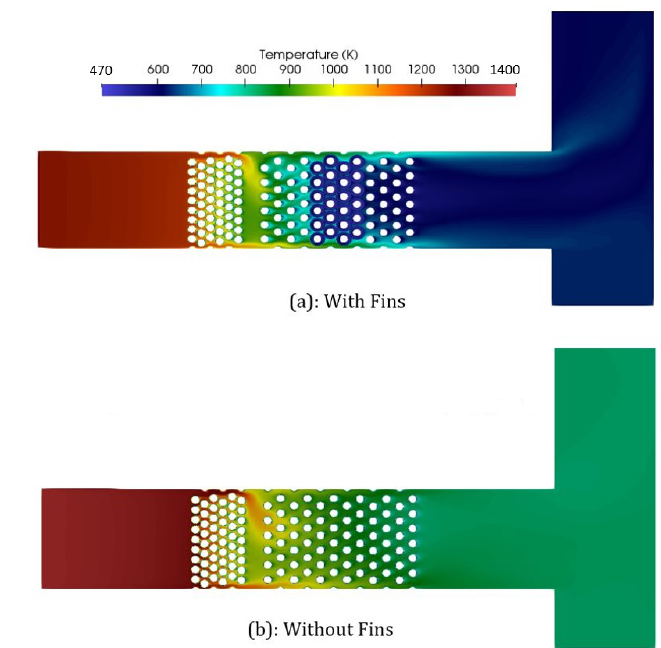
Figure 15. Temperature distribution in the convection box with and without fins on Second